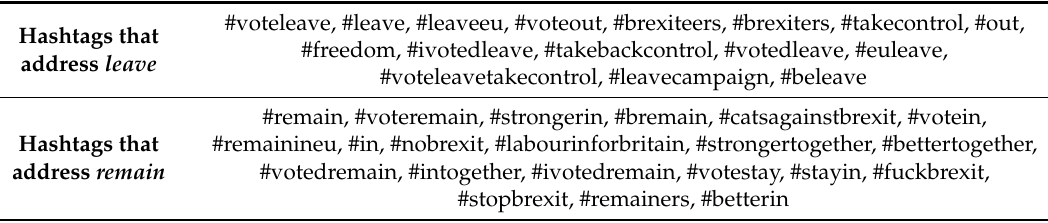
Table 2. Hashtags that address leaving the EU or remaining in the EU.